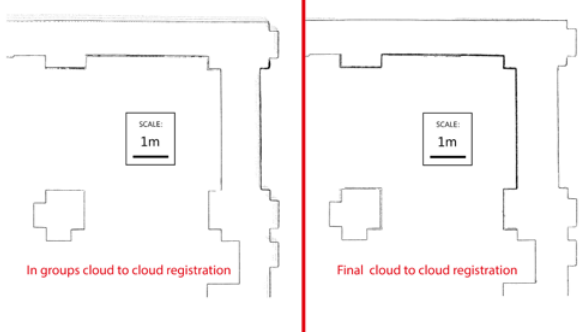
Figure 5. Alignment results before and after the final